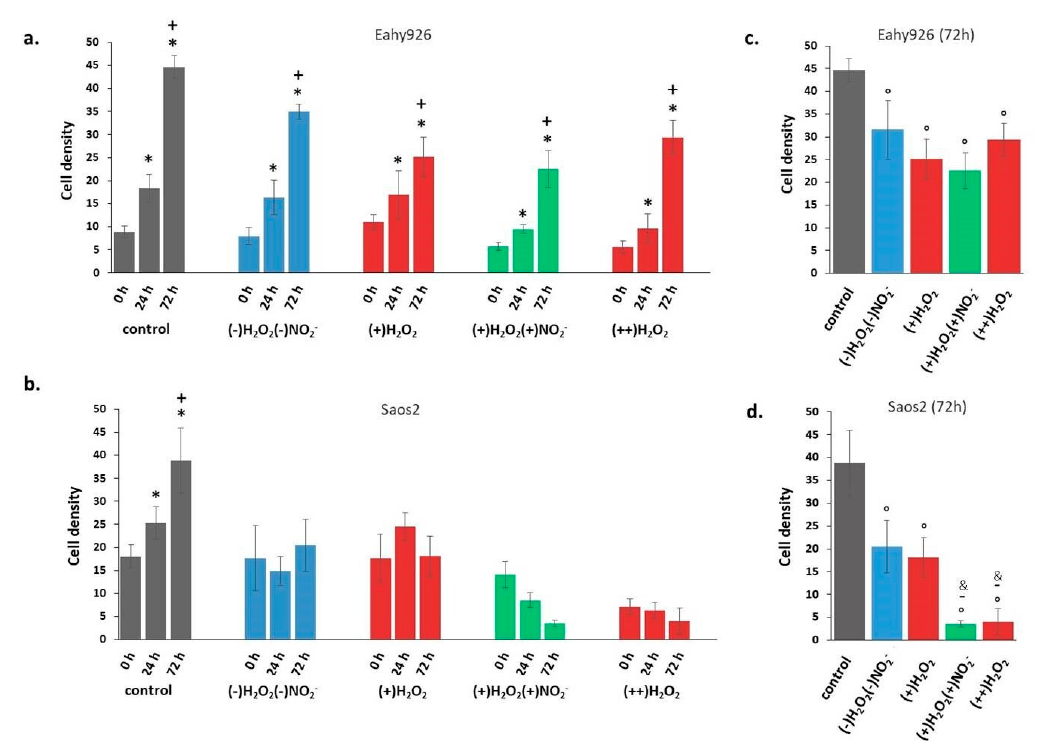
Figure 8. Cell density of cells incubated with PTWS respect to the control. ( a ) Eahy926 and ( b ) Saos2 cells at different time points (0, 24, and 72 h) after incubation in different PTWSs. ( c ) Eahy926 and ( d ) Saos2 cells after 72 h of incubation in different PTWSs. The time 0 h corresponds to cells exposed for 2h to PTWSs, PFA4% fixed, rinsed with PBS and Coomassie blue stained. One-way ANOVA + Tukey’s post-test: (*) = p < 0.01 vs. 0 h; (+) = p < 0.01 vs. 24 h; ( ◦ ) = p < 0.01 vs. control; (-)= p < 0.01 vs. (+)H 2 O 2 ; (&) = p < 0.01 vs. (-)H 2 O 2 (-)NO 2 − .